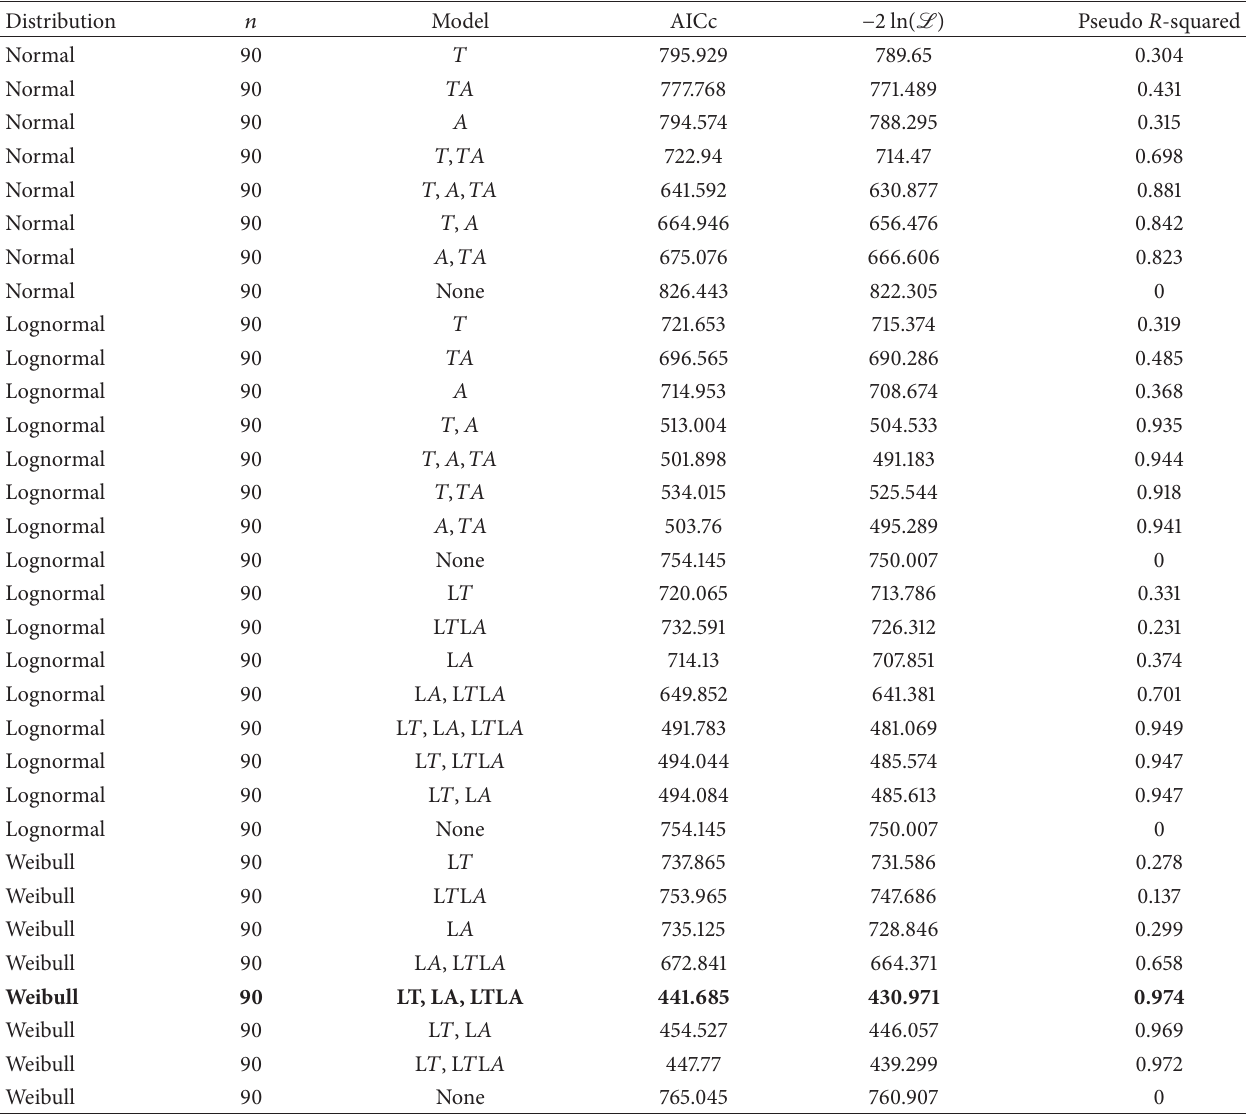
Table 4: LIFEREG procedure analysis in SAS 9.3 using normal, lognormal, and Weibull distribution utilizing observed logarithmic values of